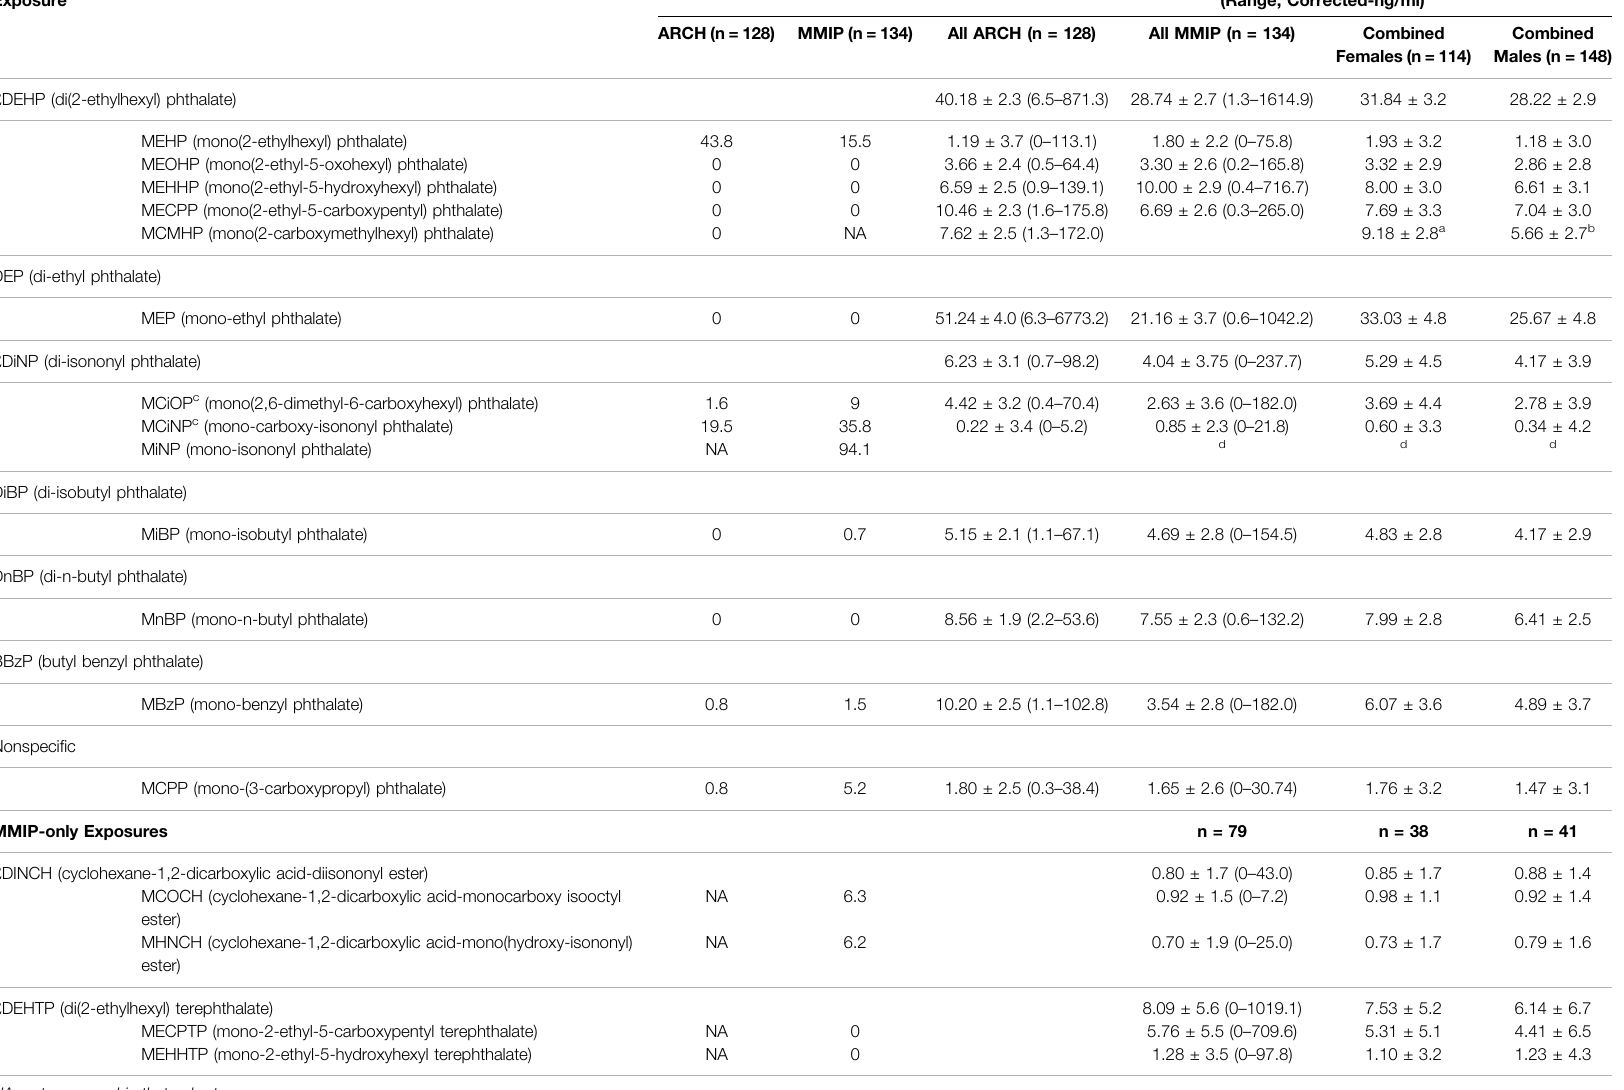
TABLE 1 | Phthalate metabolite concentrations in fi rst-trimester maternal urine